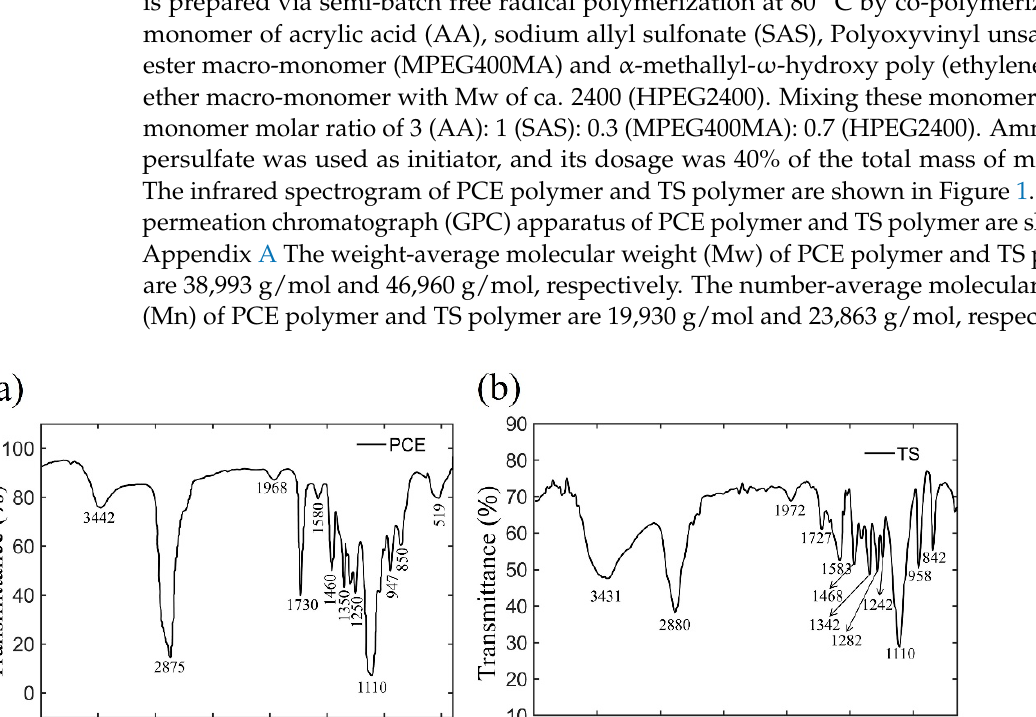
Table 1. Chemical compositions of OPC (Type II) and Nc [wt.%].